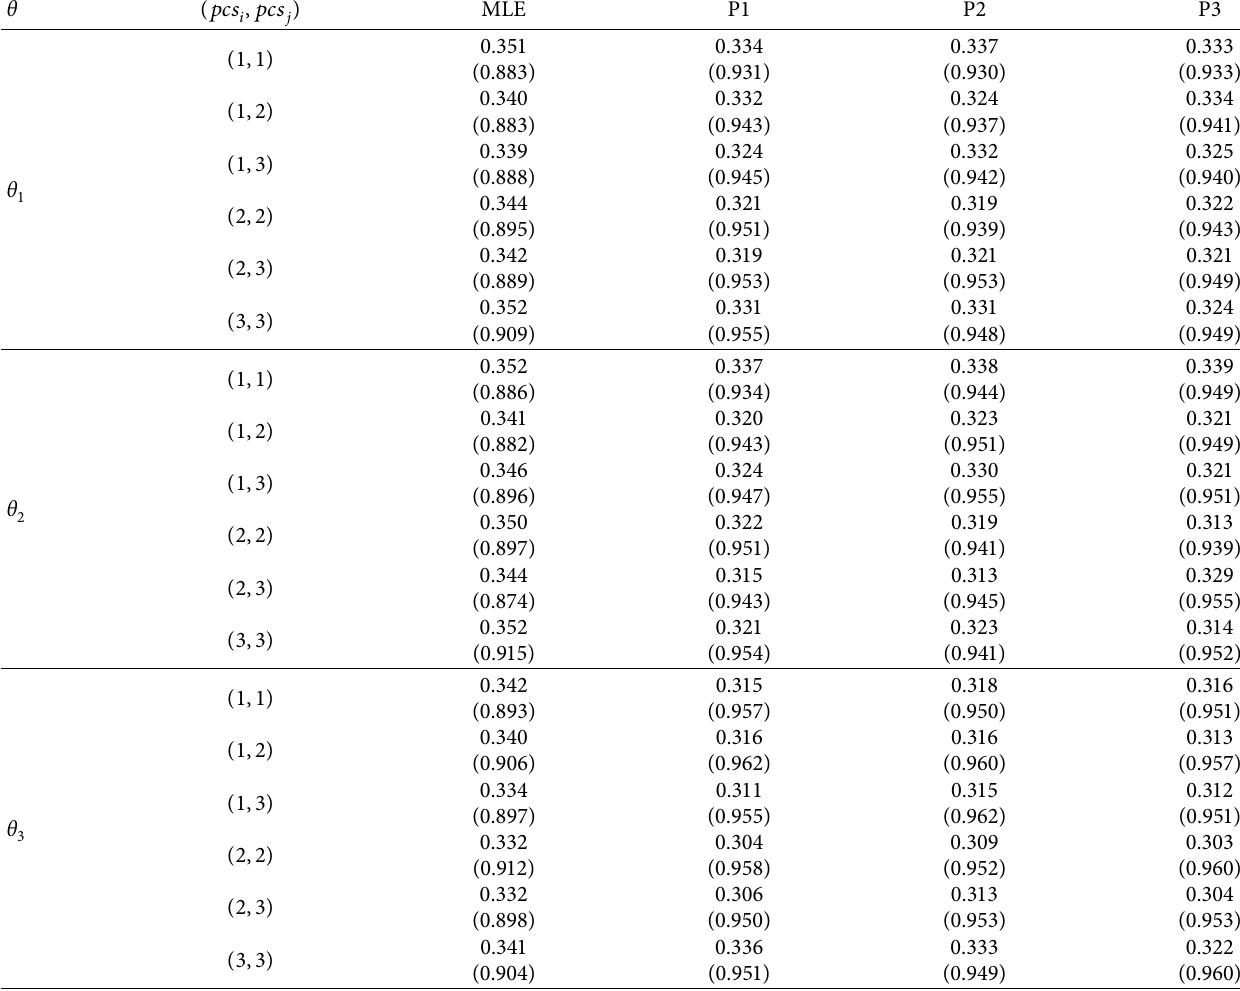
Table 3: Average of confidence/credible length (coverage percentage).